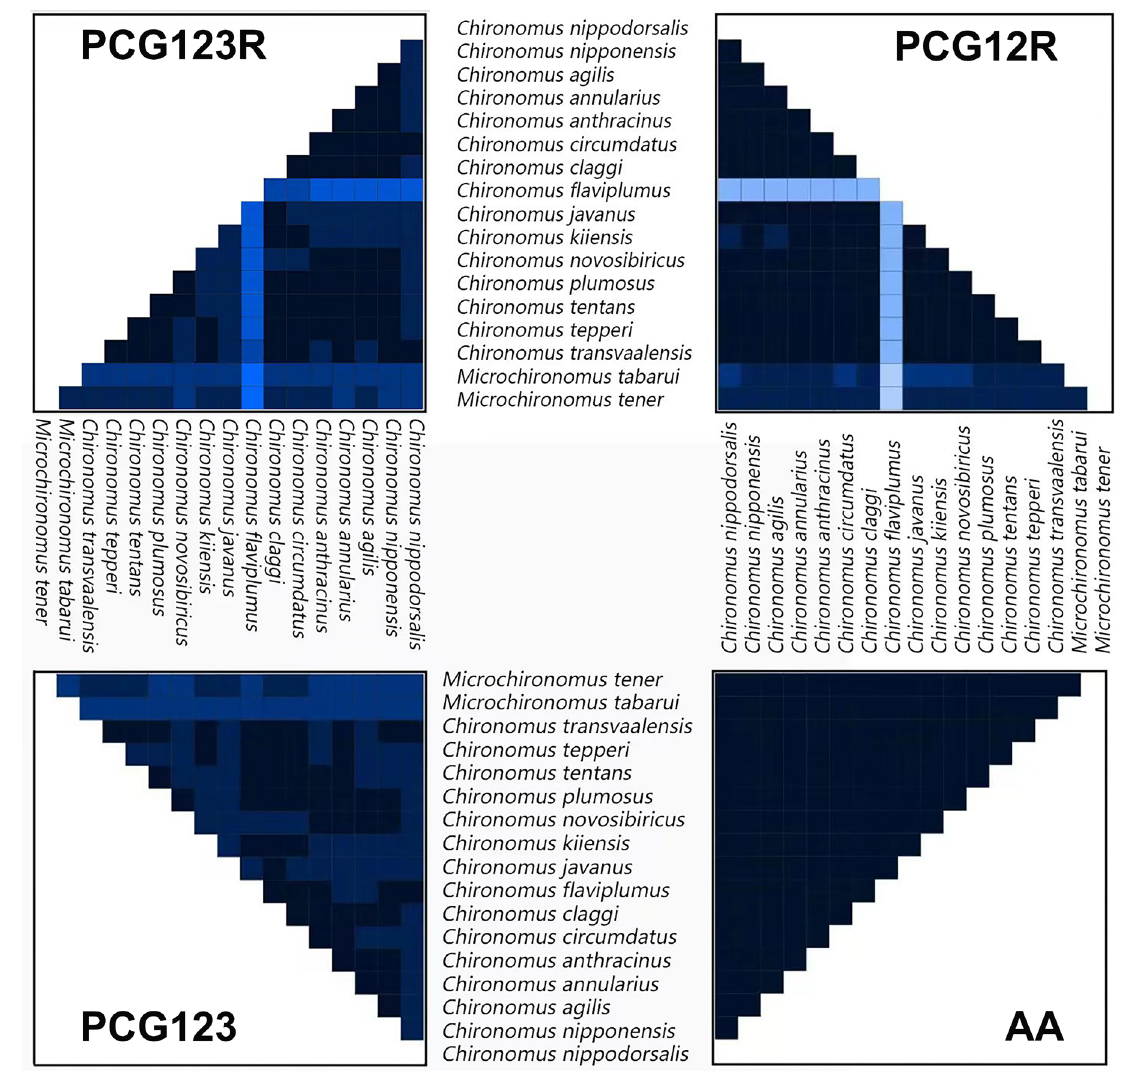
Figure 4. Heterogeneity analysis based on 13 PCGs and two rRNA sequences. Analysis based on AliGROOVE scores ranging from − 1 (strong heterogeneity between datasets; the color is red) to +1 (weak heterogeneity between datasets; the color is blue); the lighter the color of the color block of each dataset, the stronger the heterogeneity, and the darker the color, the weaker the heterogeneity.